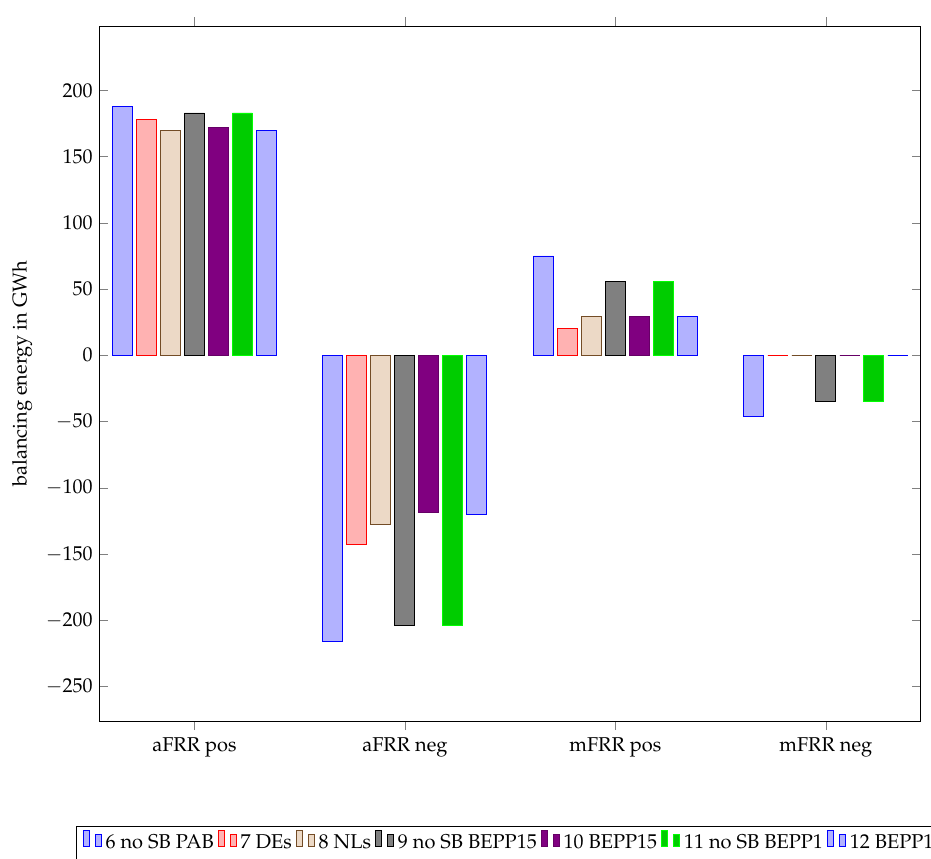
Figure 9. Smart Balancing simulation - Demand of balancing energy in synthetic scenarios Figure 9. Smart balancing simulation: demand of balancing energy in synthetic scenarios. In contrast to the demand of FRR, the related costs did differ, not only with the imbalance pricing, but also with the clearing scheme. Figure 10 illustrates that